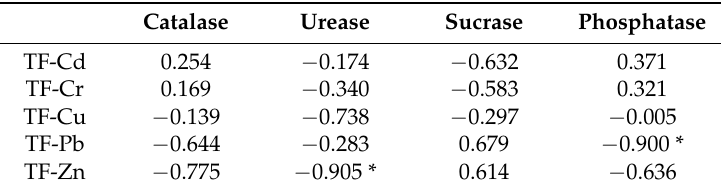
Table 4. The Pearson correlations among soil enzyme activities and transfer factors of different heavy metals of soil.